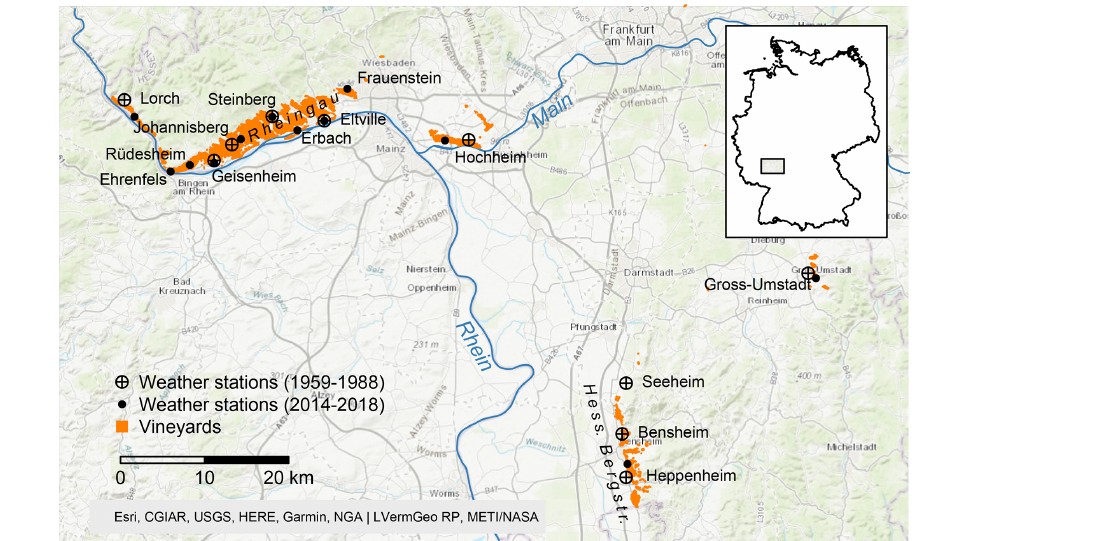
Figure 1. Map showing the wine-growing regions Rheingau and Hessische Bergstraße and the locations of weather stations (source of the base map (modified): Esri,